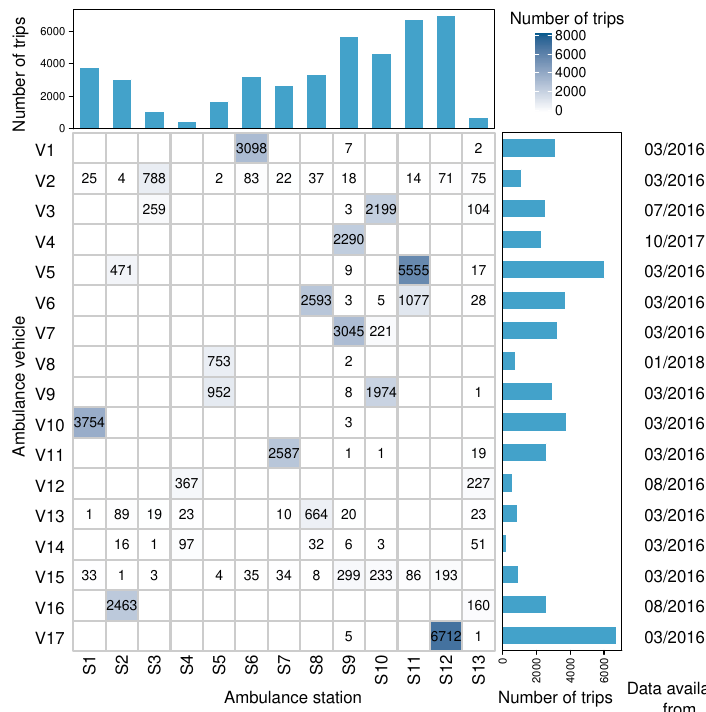
Figure 4. Number of trips extracted from the Falck dataset for each ambulance and initial ambulance station. For each ambulance, we report the start date of the time period for which the data were available for analysis.